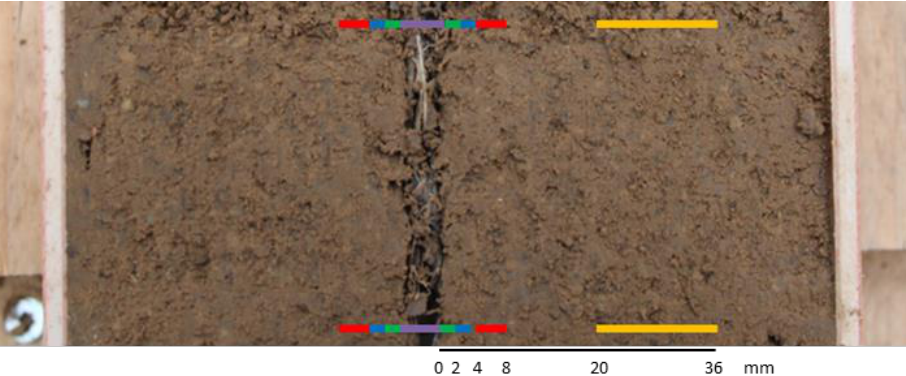
Figure 1. Sampling of the biopore lumen (purple), biopore sheath (green, blue, red) and bulk soil (yellow). Lateral distances in [mm] from the pore wall surface.